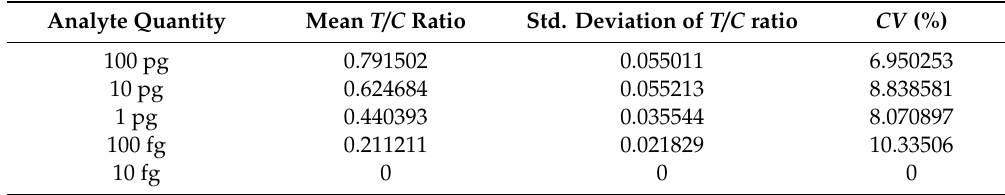
Table 4. Mean, std. deviation and coe ffi cient of variation of test to control line signal intensity ( T / C ) ratios for each of the analyte quantities of the LFA sets.